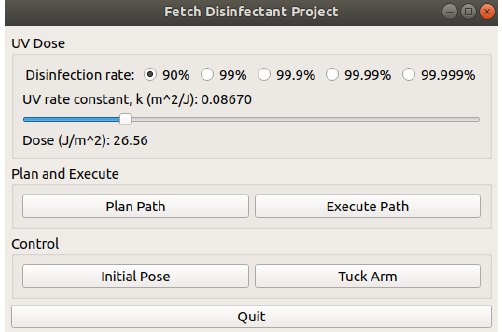
Figure 11. The robot control interface. This allows the user to set the disinfection parameters, and to start the disinfection routine, along with controlling some other basic robot movements.